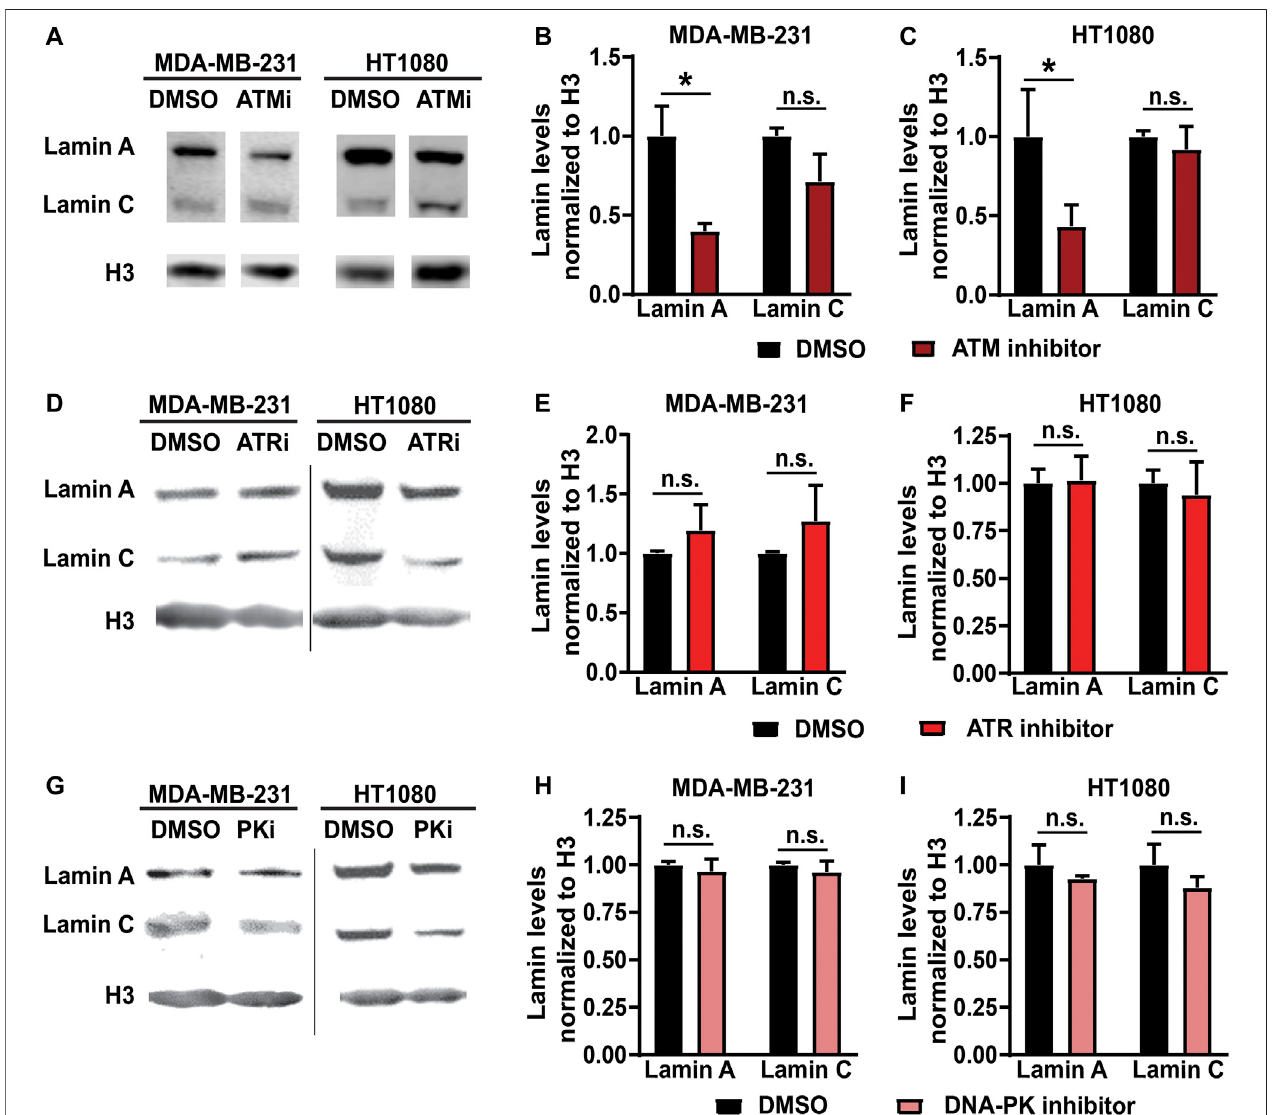
FIGURE1| InhibitionofATMbutnotATRorDNA-PKreduceslaminAlevels. (A) RepresentativeimmunoblotforlaminAandlaminCofMDA-MB-231andHT1080 cells treated with 10 µM of ATM inhibitor KU-55933 or 0.1% DMSO for 48 h. Histone H3 was used as loading control. (B) Quanti fi cation of lamin A and C protein levels fromimmunoblotsofMDA-MB-231cells,basedonthreeindependentexperiments.LaminlevelswerenormalizedtoDMSOtreatedcells.*, p < 0.05basedonTwo-way ANOVA with Tukey ’ s multiple comparison test. N = 3 (C) Quanti fi cation of lamin A and C protein levels from immunoblots of HT1080 cells, based on three independent experiments. Lamin levels were normalized toDMSO treated cells. *, p < 0.05basedon Two-way ANOVA withTukey ’ smultiple comparison test. N =3 (D) Representative immunoblot for lamin Aand lamin C of MDA-MB-231 and HT1080 cells treated with 10 µM of ATR inhibitor VE-821 or 0.1% DMSO for 48 h. Histone H3 wasusedasloadingcontrol. (E) Quanti fi cationoflaminAandCproteinlevelsfromimmunoblotsforMDA-MB-231cells,basedonthreeindependentexperiments.Lamin levels were normalized to DMSO treated cells. Differences were not statistically signi fi cant (n.s.) based on two-way ANOVA. N = 3 (F) Quanti fi cation of lamin A and C protein levels from immunoblots for HT1080 cells, based on three independent experiments. Lamin levels were normalized to DMSO treated cells. Differences were not statistically signi fi cant (n.s.) based on two-way ANOVA. N = 3 (G) Representative immunoblot for lamin A and lamin C of MDA-MB-231 and HT1080 cells treated with 5 µMofDNA-PKinhibitor NU7441or0.1%DMSOfor48 h.HistoneH3wasusedasloadingcontrol. (H) Quanti fi cationoflaminAandCproteinlevelsfromimmunoblots for MDA-MB-231 cells, based onthree independent experiments. Lamin levelswerenormalized toDMSO treated cells. Differences werenot statistically signi fi cant(n.s.) basedontwo-way ANOVA. N =3. (I) Quanti fi cationoflaminAand Cprotein levelsfromimmunoblotsforHT1080 cells,basedonthreeindependentexperiments. Lamin levels were normalized to DMSO treated cells. Differences were not statistically signi fi cant (n.s.) based on two-way ANOVA. N = 3 Error bars in this fi gure represent mean ± s.